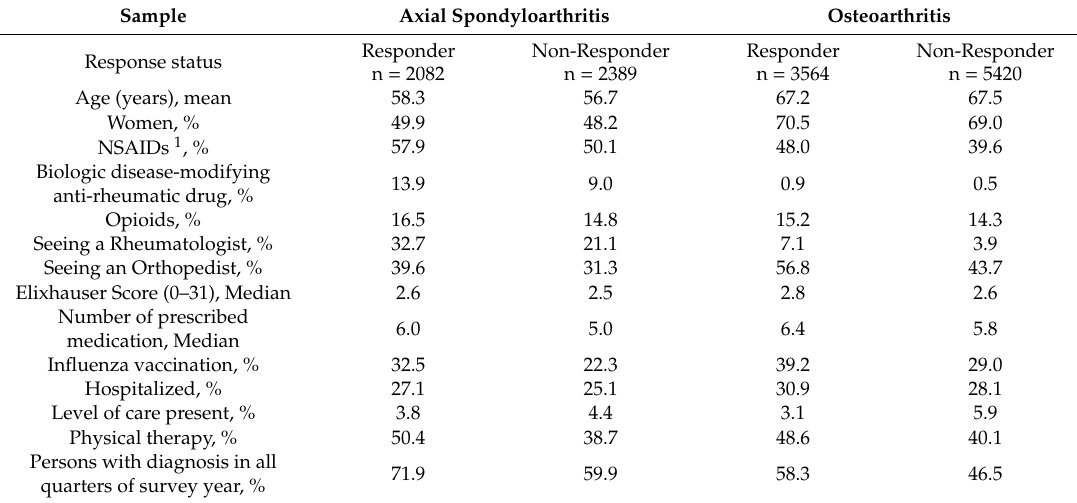
Table 1. Characteristics of responders and non-responders in the axial spondyloarthritis and osteoarthritis